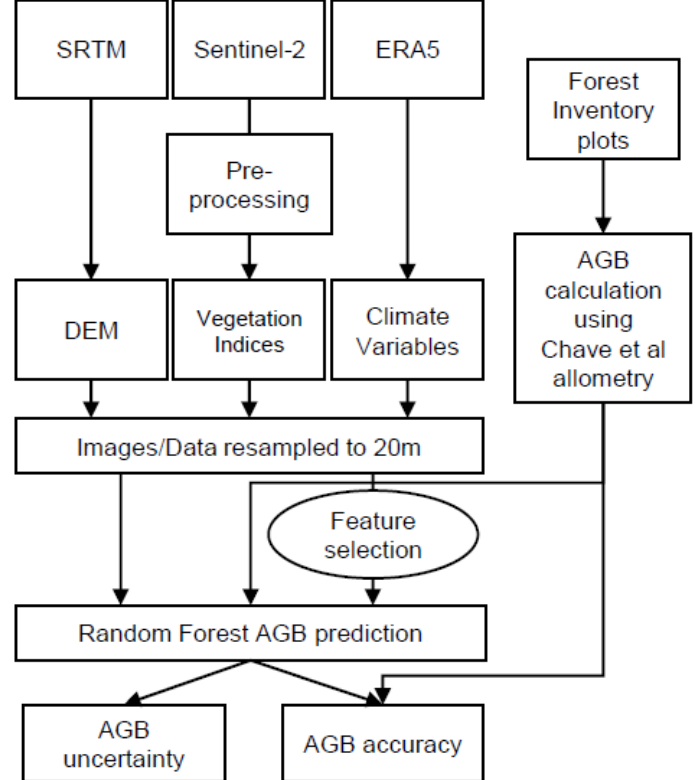
Figure 2. Methodological workflow showing data sources, analytical procedures, final output and accuracy assessment. Climate variables used were air temperature, precipitation, relative humidity and soil moisture. Vegetation indices are given in Section 2.3.1 below.